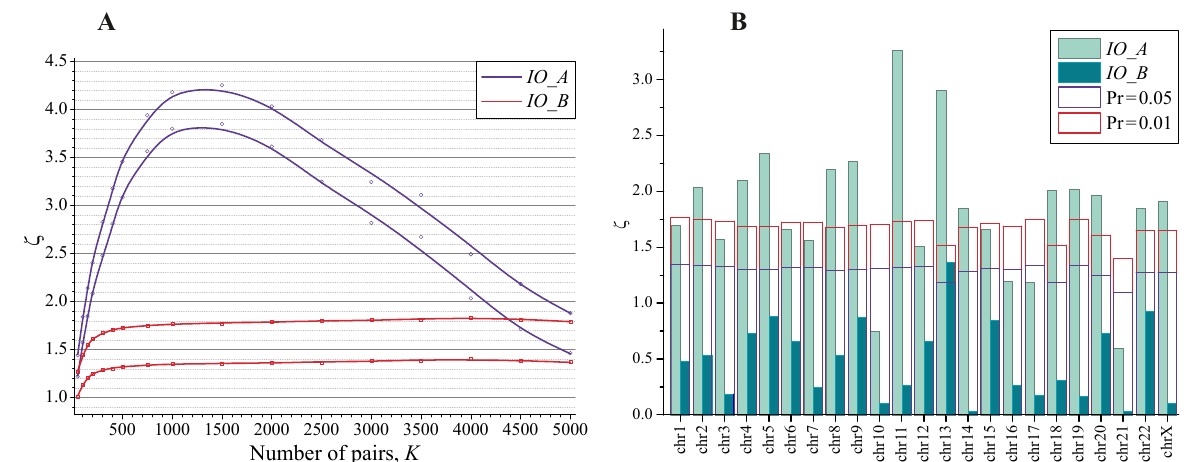
(cid:12) (cid:12) (cid:12) (cid:12) (cid:12) (cid:12) (cid:12) (cid:12) ζ ( a ) ζ ( b ) (cid:12) (cid:12) (cid:12) and (cid:12) (Equations (1), (7), and (15)) on the IO IO (cid:12) (cid:12) (cid:12) (cid:12) (cid:12) (cid:12) (cid:12) (cid:12) ζ ( a ) ζ ( b ) (cid:12) (cid:12) (cid:12) and (cid:12) over human chromosomes IO IO